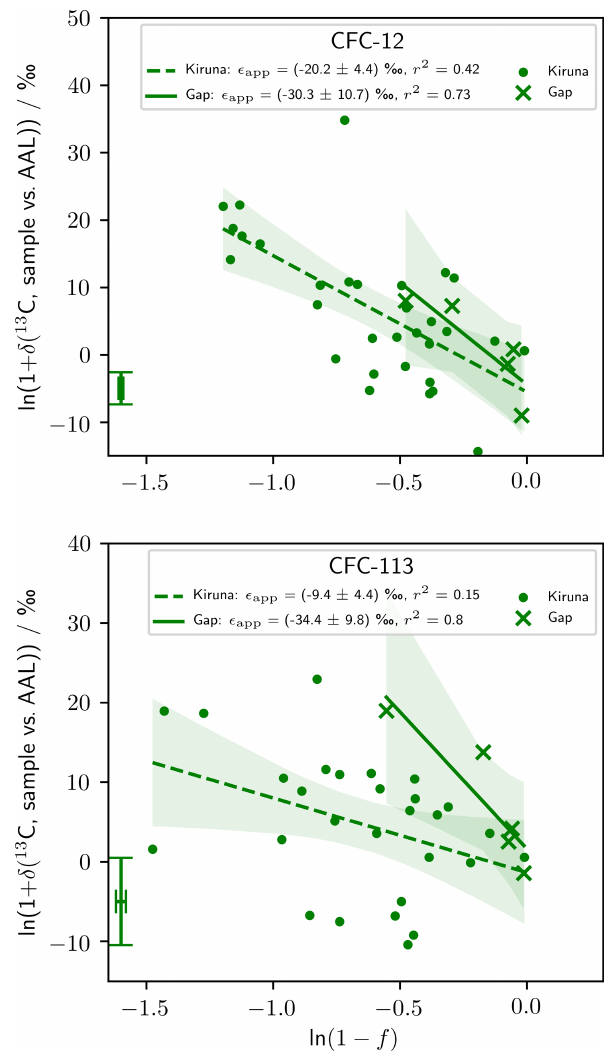
Figure 3. Rayleigh plots of our stratospheric measurements. The linear regression (lines) and 95% confidence bounds on the regres- sion (shading) are shown for the high-latitude (Kiruna) and mid- latitude (Gap) data sets. The gradients of these regressions, corre- sponding to (cid:15) app , are given in the legend with 1 standard error. The error bar in the bottom left corner of each graph shows the median repeatability of the reference gas measurements over the measure- ment days and the median error deriving from the fractional release factor. CFC-11 data are presented in Appendix